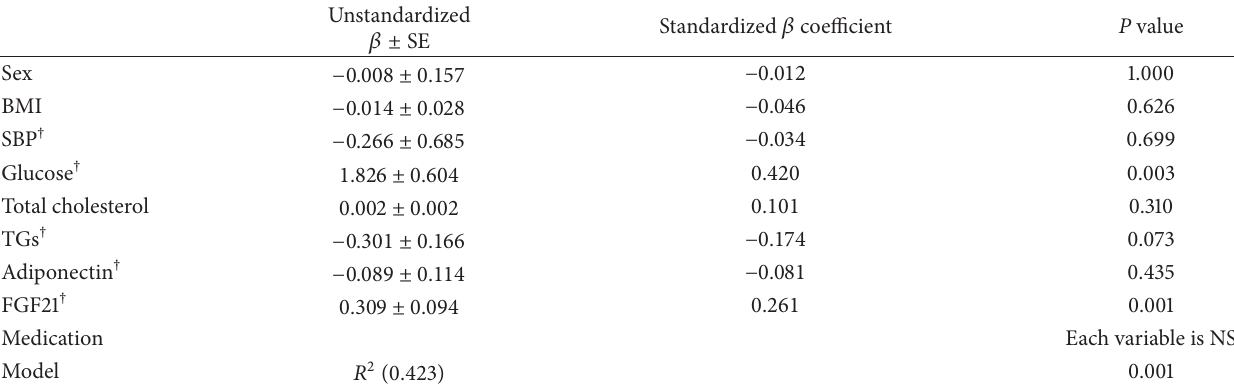
Table 5: Correlation between circulating CTRP1 levels and clinical data by multivariate analysis.